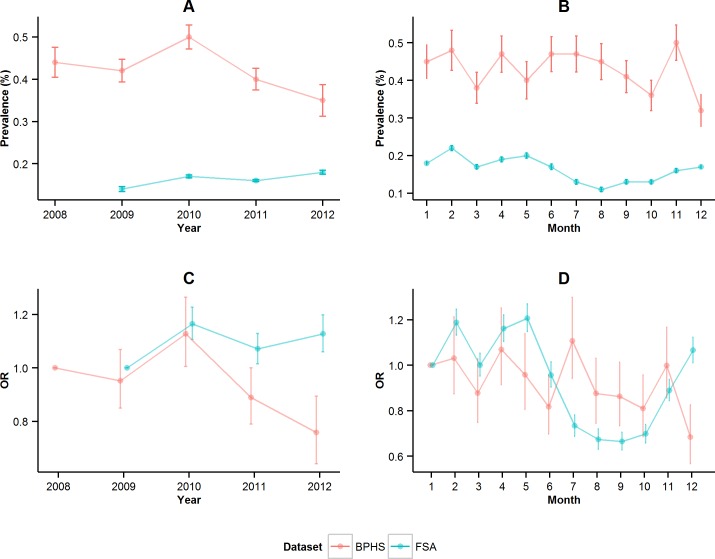
Tail bite lesions in the two datasets (BPHS, FSA).Prevalence estimate (dots) and 95% confidence interval (bars) from 2008 to 2012 (A) and from January (1) to December (12) (B). Generalised Linear Mixed Model odds ratio (OR) (dots) and 95% confidence interval (bars) from 2008 to 2012 (C) and from January (1) to December (12) (D).